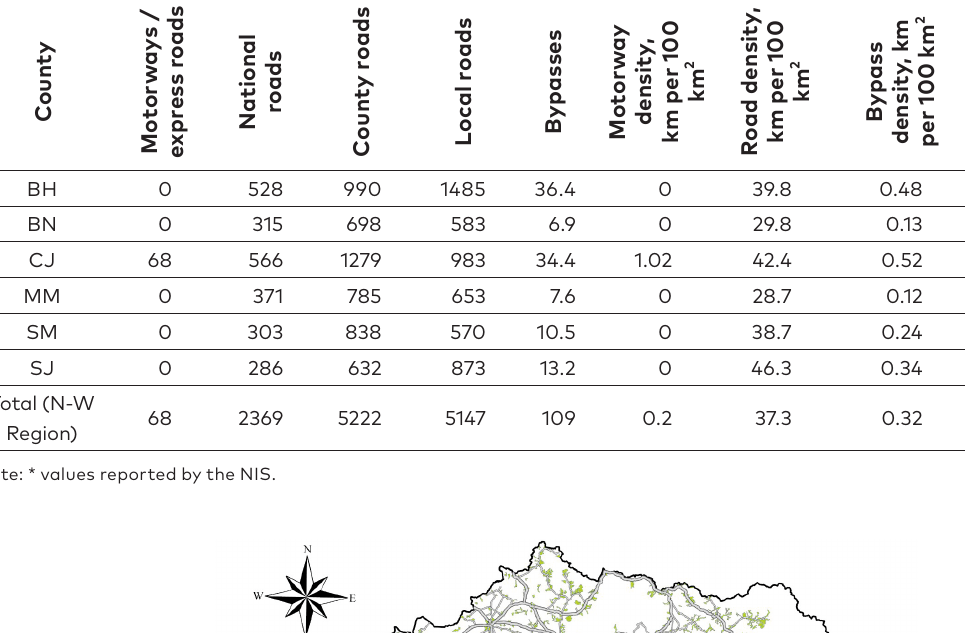
motorization rate in the N-W Region has increased over the study period, from 261 to 333 cars per 1000 inhabitants, road network density did not vary significantly, increasing by 59 km in the total length (Romania National Institute for Statistics,